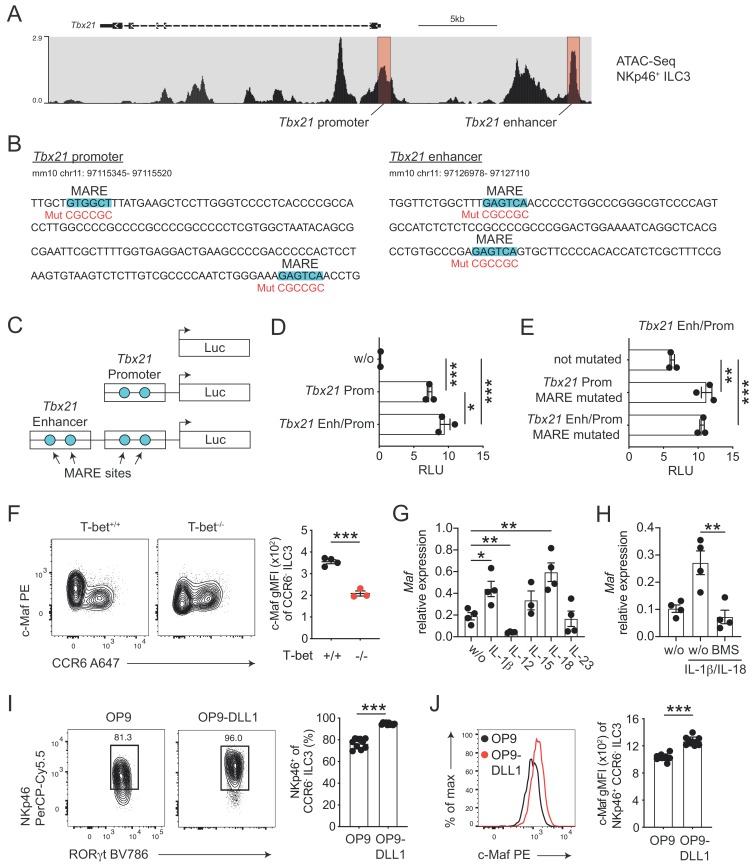
c-Maf directly represses T-bet as part of a negative feedback loop.(A) Representative ATAC sequencing tracks across the Tbx21 locus of NKp46+ ILC3s (Shih et al., 2016). The Tbx21 promoter and enhancer regions are highlighted in red (Yang et al., 2007). ATAC sequencing tracks were visualized using the WashU browser from the Cistrome project (Mei et al., 2017). (B) Positioning of putative Maf response elements (MARE) within the Tbx21 promoter and enhancer (highlighted in blue). Depicted sequences represent selected regions of the Tbx21 promoter and enhancer. Mutated sequences are shown in lower lines in red. (C) Schematic representation of plasmids containing the Tbx21 promoter/enhancer linked to the firefly luciferase reporter gene (Luc). Blue dots indicate MARE sites within the Tbx21 promoter and enhancer region. (D) Relative luciferase activity (RLU) of different reporter constructs driven by the Tbx21 promoter alone or in combination with an enhancer sequence compared to a promoterless (w/o) control vector (pGL3 basic) (n = 3, mean ± SEM, *p<0.05, ***p<0.001). (E) Analysis of c-Maf-dependent suppression of luciferase activity. The MARE sites within the Tbx21 promoter or the Tbx21 promoter and enhancer were mutated in the Tbx21 enhancer/promoter construct. Comparison of RLU between unmutated and mutated Tbx21 enhancer/promoter constructs upon c-Maf overexpression (n = 3, mean ± SEM, ***p<0.001). All reporter assay data are pooled from three independent experiments. (F) Expression of c-Maf by siLP CCR6- ILC3s from T-bet-deficient (T-bet-/-) and -sufficient (T-bet+/+) mice. Representative flow cytometric profiles are shown on the left; graph on the right shows quantification of c-Maf gMFI (n = 4, mean ± SEM, ***p<0.001). (G–H) Sort-purified siLP NKp46+ CCR6- ILC3s from RorcCre
R26EYFP mice were cultured in vitro for 36 hr in the presence of IL-7/SCF (w/o) or IL-7/SCF plus indicated cytokines. Subsequently, Maf expression was measured by qPCR (n = 4, mean ± SEM, *p<0.05, **p<0.01, ***p<0.001). In one condition the NF-κb inhibitor BMS-345541 (BMS) was added at 1 μM to the culture. Data are pooled from two independent experiments each with two replicate wells. (I) Sort-purified siLP NKp46+ CCR6- ILC3s from RorcCre
R26EYFP mice were cultured in the presence of IL-7/SCF on OP9 or OP9-DLL1 stromal cells as indicated. After 12 days, cells were analysed by flow cytometry for the cell surface expression of NKp46. Representative contour plots are shown on the left (pregated on CCR6- ILC3s); graph on the right shows quantification of the frequency of NKp46+ cell among CCR6- ILC3s (n = 10, mean ± SEM, ***p<0.001). Data are pooled from two independent experiments with 4 to 6 replicate wells. (J) Expression of c-Maf by NKp46+ CCR6- ILC3s cultured on OP9 or OP9-DLL1 cells. Representative histogram is shown left; graph on the right shows quantification of c-Maf gMFI (n = 10, mean ± SEM, ***p<0.001). All statistical differences were tested using an unpaired Students’ t-test (two-tailed).